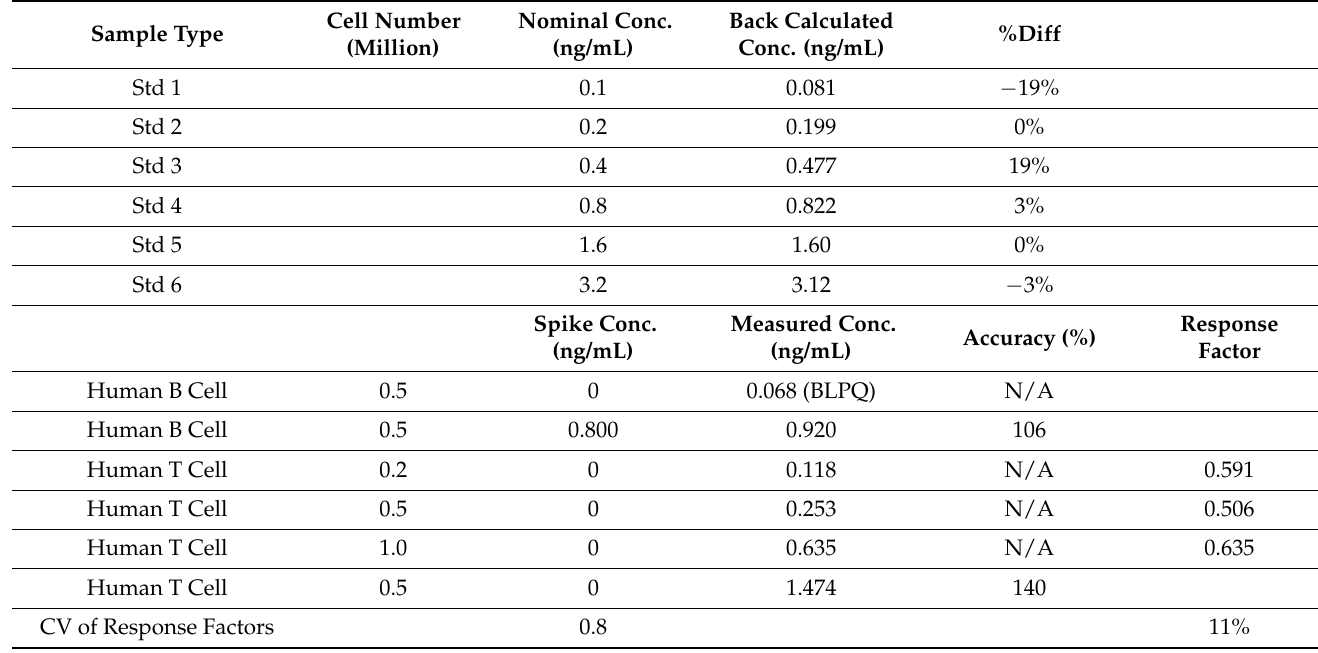
Table 2. Spiked Recovery and Parallelism of the CTLA4